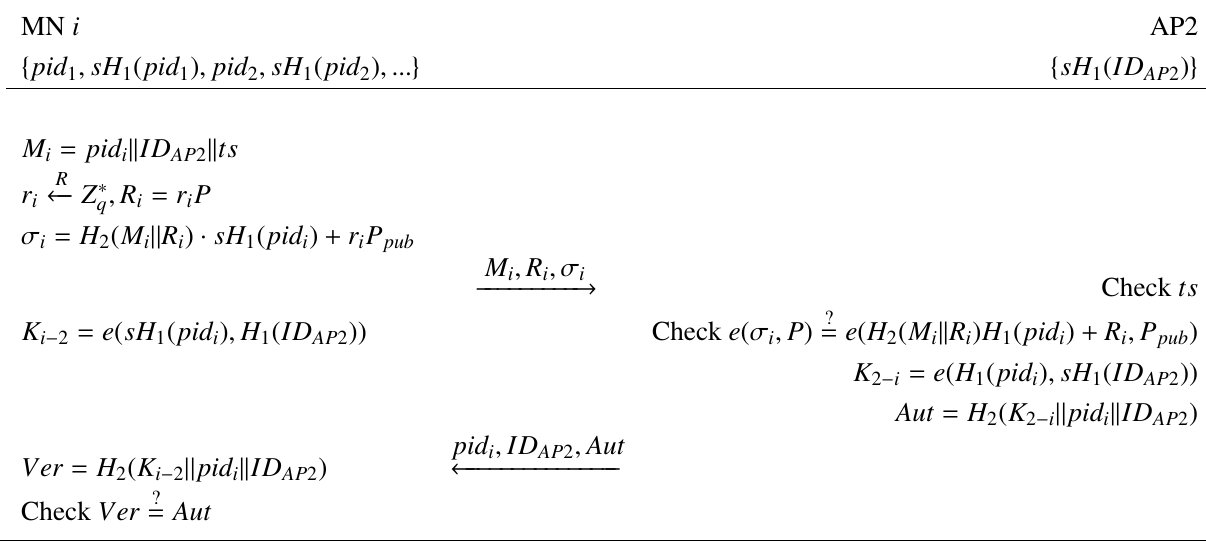
Figure 2. The handover authentication phase in our